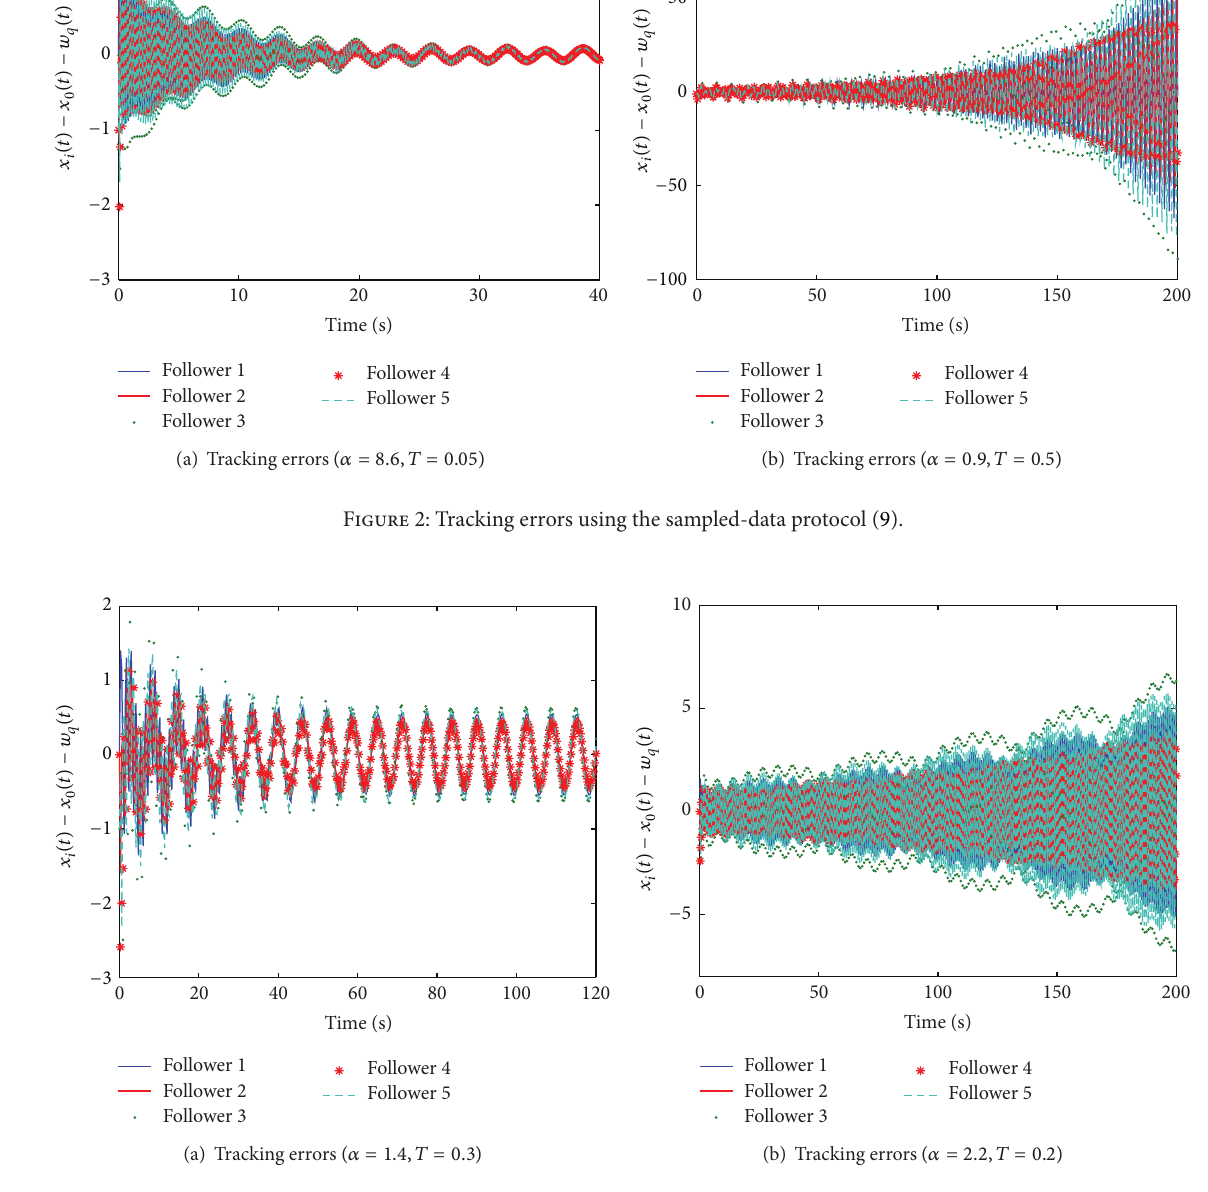
Figure 3: Tracking errors using the sampled-data protocol